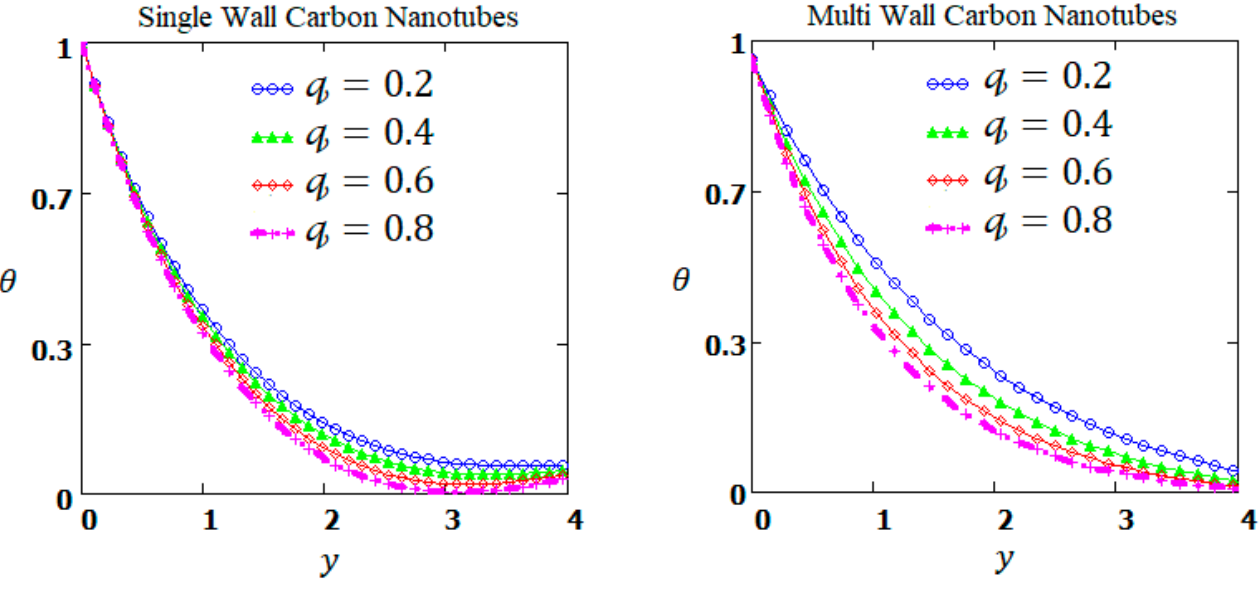
Figure 5. Temperature distribution of single and multi-wall carbon nanotubes without ripple visualizations for 2-D graphs subject to varying fractional parameter.